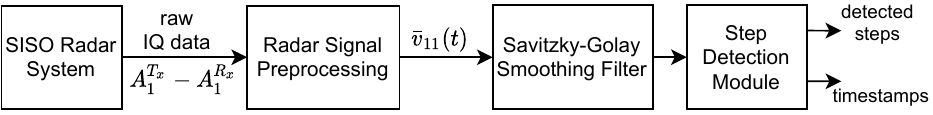
Figure 4. The block diagram of the RF-based step counter for a SISO radar system.